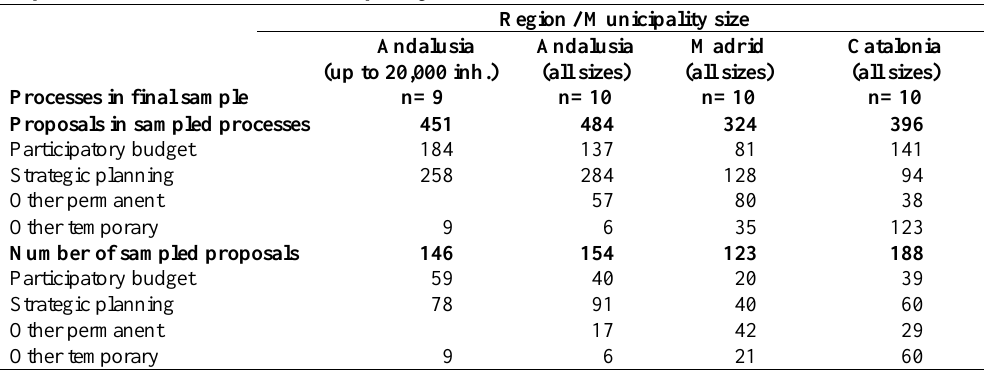
Proposal Distribution across Participatory Processes